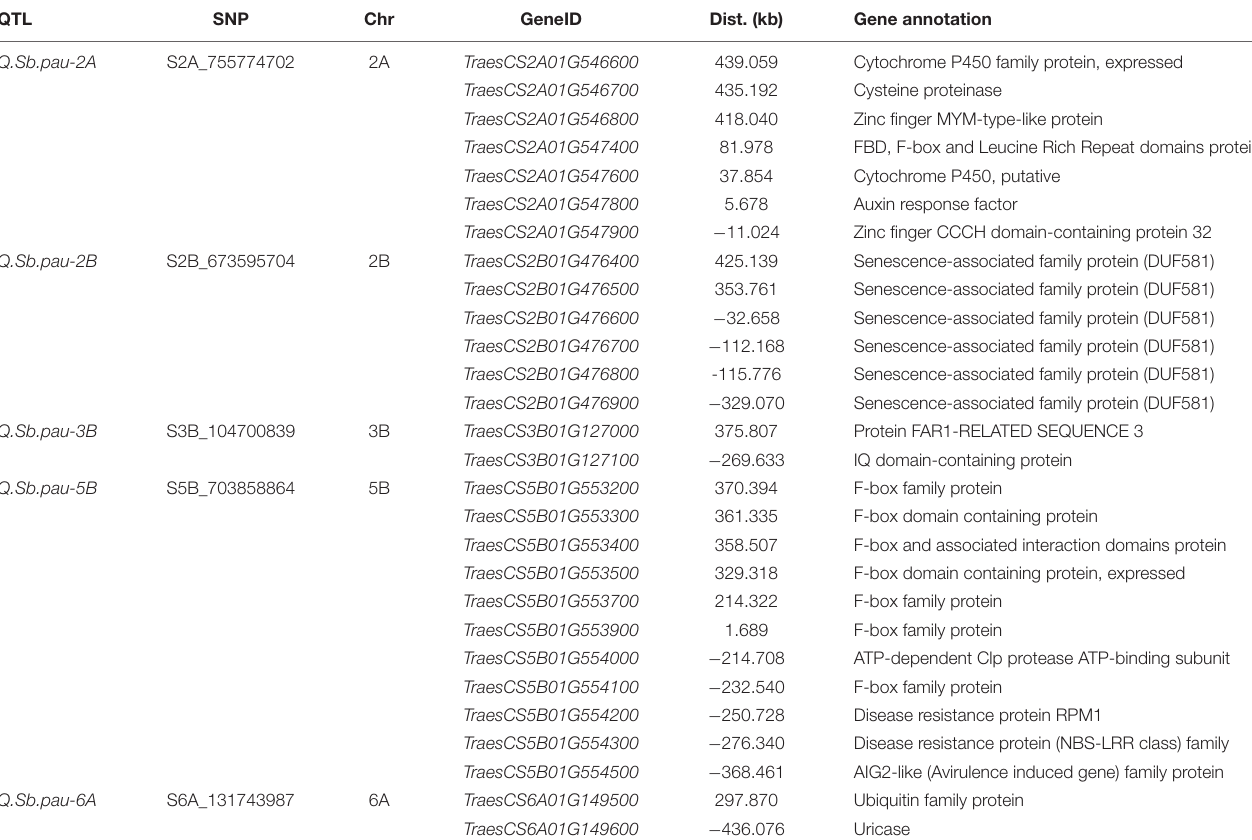
TABLE 3 | QTLs along with SNPs and corresponding proteins and functional gene annotation elucidated based on the high confidence genes from wheat reference sequence (RefSeq V1.0) annotation database. QTL SNP Chr GeneID Dist. (kb)